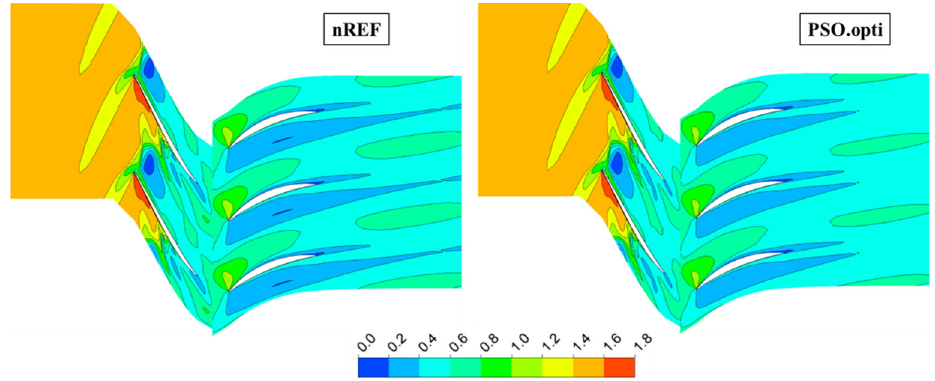
Figure 18. Mach number contours at 98% blade span at near-stall conditions.